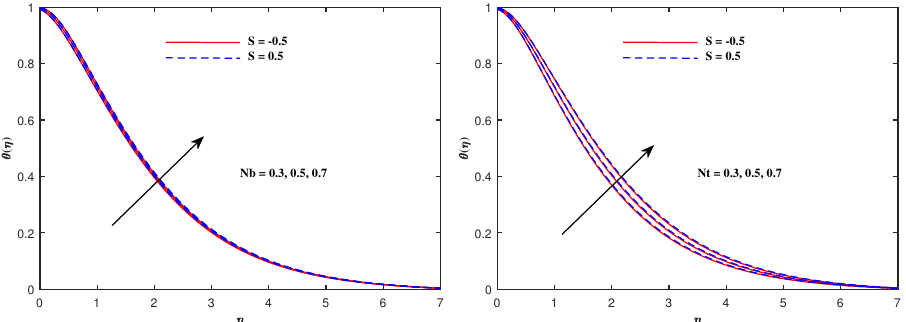
Figure 6. Temperature variation with Nb and Nt